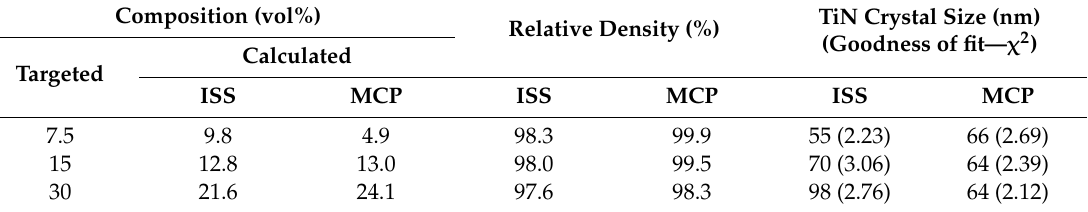
Table 1. Relative density and TiN crystal size as a function of composition, as determined by the Rietveld analysis.